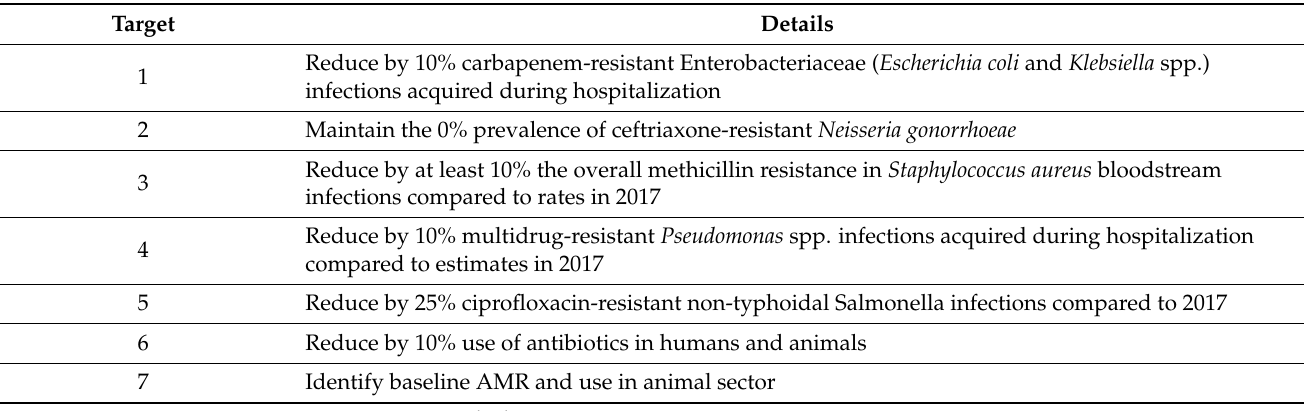
Table 2. Philippine National Action Plan targets for 2019–2023